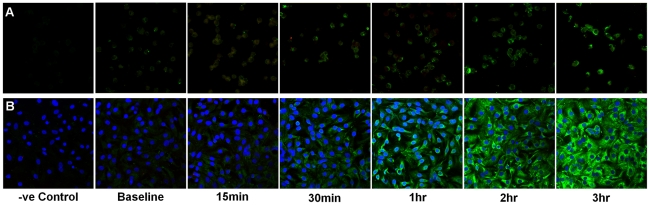
Effect of MALP-2 on alveolar macrophage and ATII cell TLR-4 protein expression.Alveolar macrophages (A) and ATII cells (B) were exposed to MALP-2 (100 ng/ml) over a three hour time course. Cells were fixed in methanol at 0, 15 mins, 30 mins, 1 hr, 2 hrs and 3 hrs and stained with FITC-labelled anti-TLR4 antibody. TLR4 expression was visualised using confocal microscopy. Images were taken through the centre of the cell to visualise cytosolic as well as cell surface expression. Data representative of 3 separate subjects.